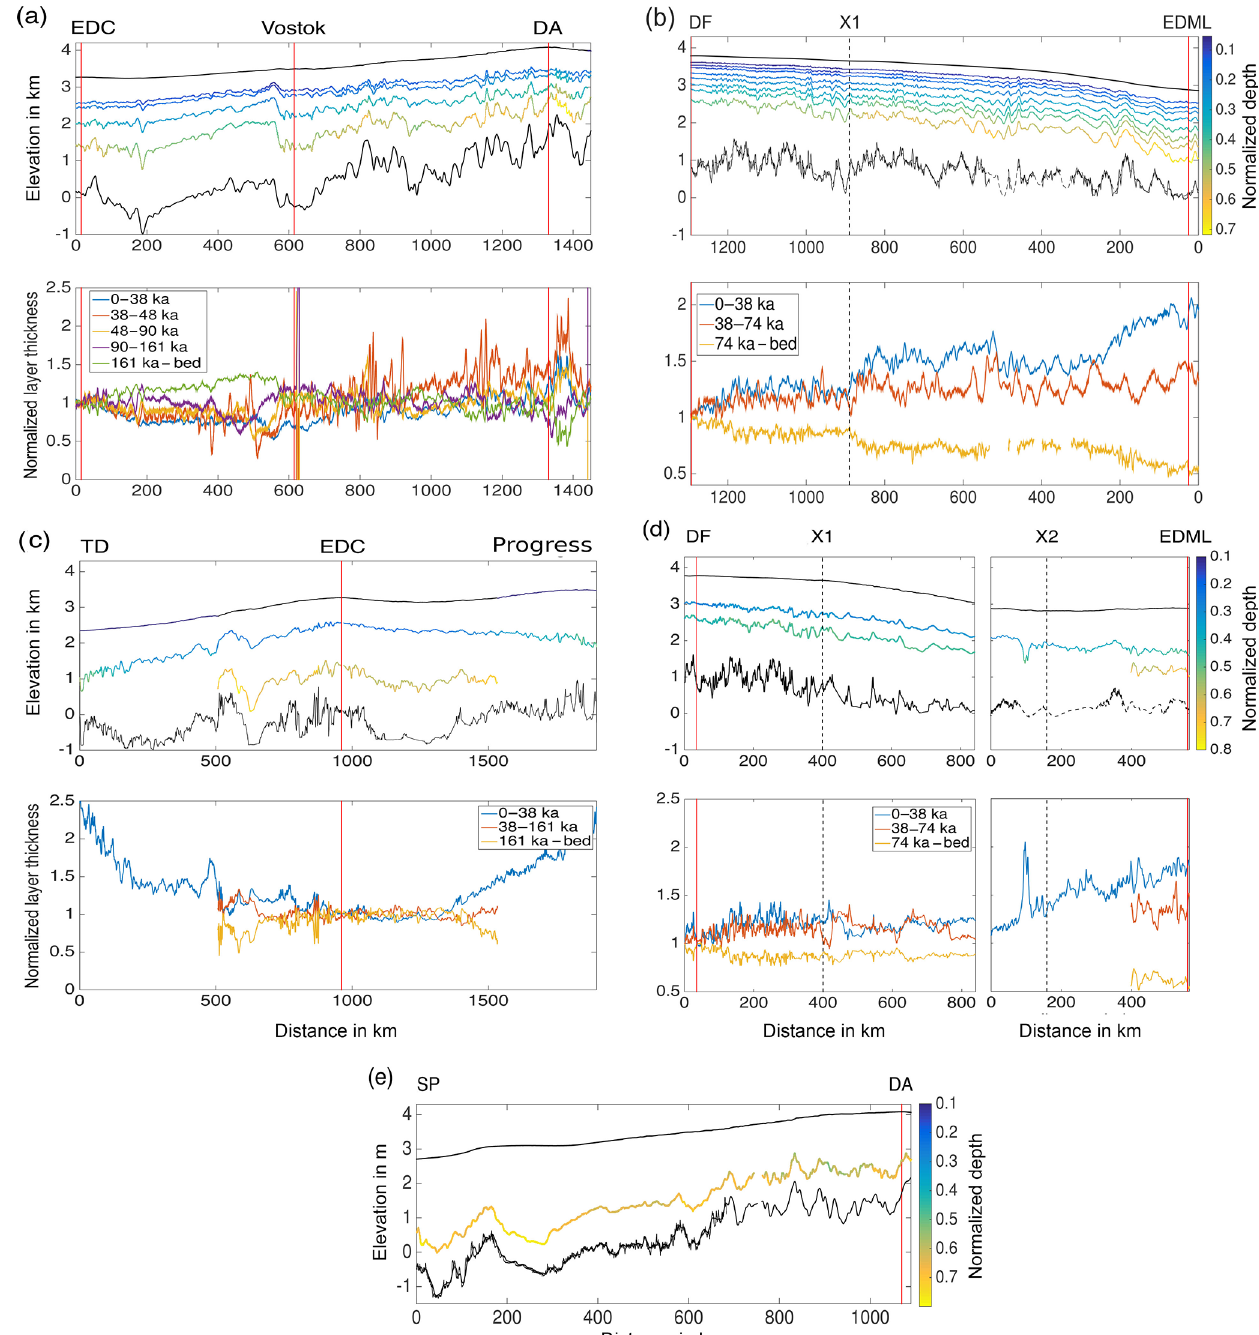
Figure 2. Sections of some example profiles. The profile locations can be identified via the drill sites and crossing points (vertical lines and labels at the top of subfigures). Top panels show the elevations (WGS84) of ice surface, bed and IRHs. Colors scale with normalized (by ice thickness) IRH depths. The second panels show normalized layer thicknesses, divided by their normalized thicknesses at EDC (a, c) and DF (b, d) ,